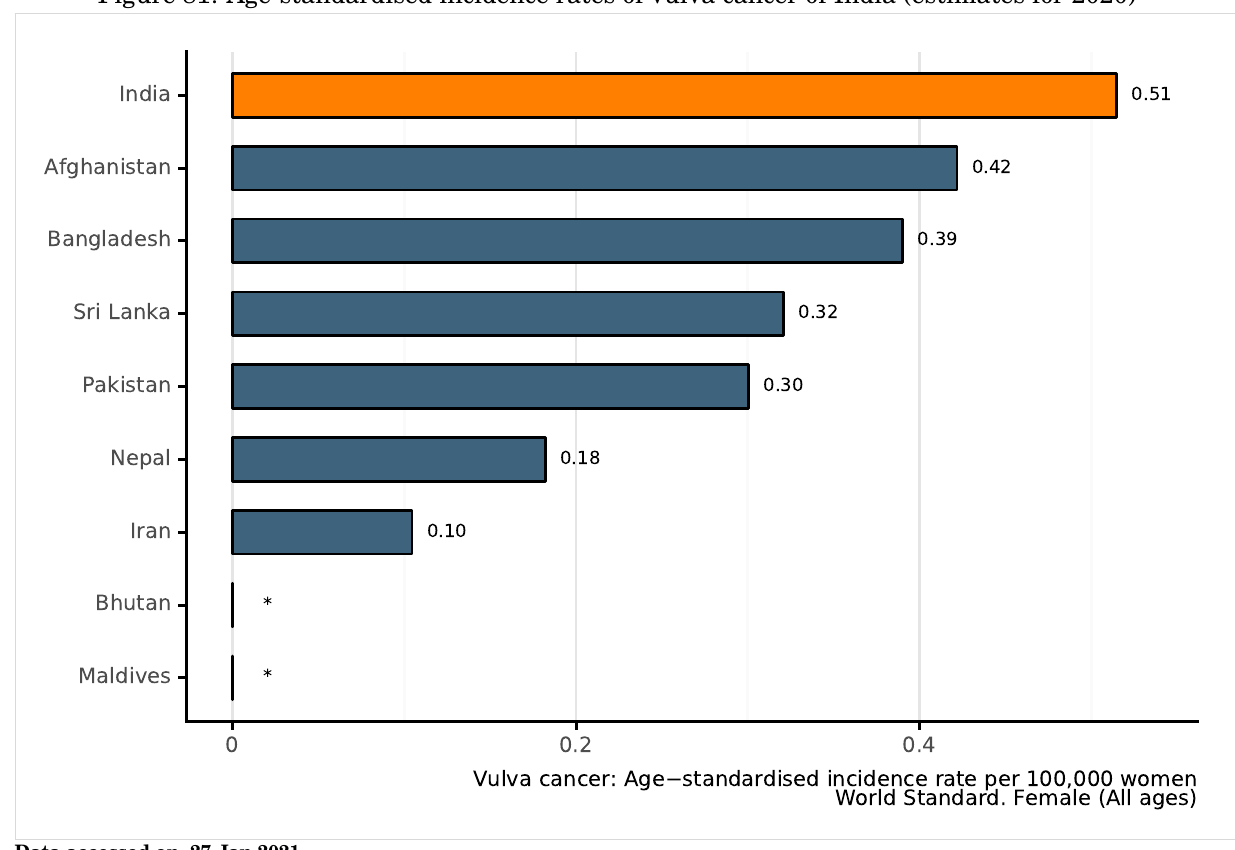
0 0.2 0.4 Vulva cancer: Age standardised incidence rate per 100,000 women World Standard. Female